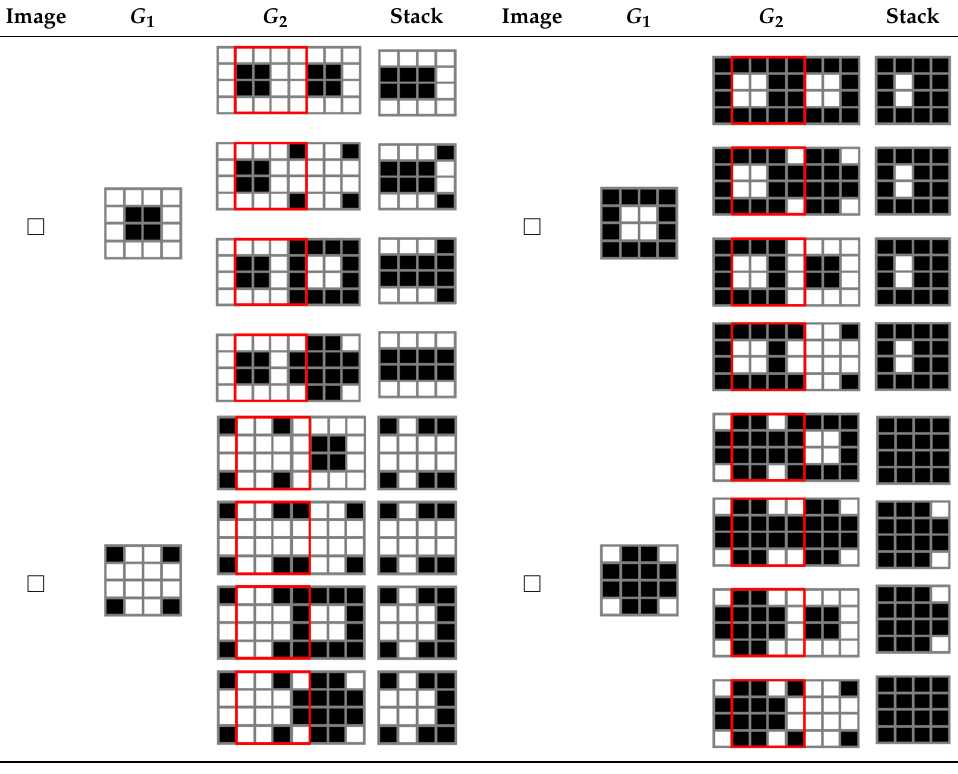
Table 4. The designed patterns for n = 4.